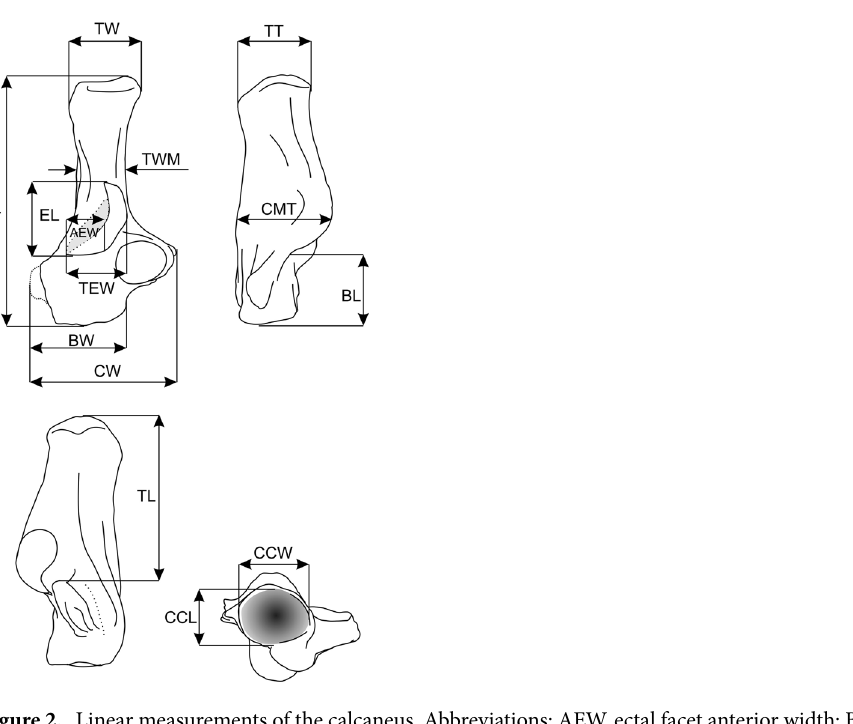
Figure 2. Linear measurements of the calcaneus. Abbreviations: AEW, ectal facet anterior width; BL, calcaneal body length; BW, calcaneal body width; CCL, calcaneocuboid facet length; CCW, calcaneocuboid facet width; CL, calcaneus length; CMT, calcaneus maximum thickness; CW, calcaneal width; EL, ectal facet length; TEW, ectal facet total width; TL, tuber calcanei length; TT, tuber calcanei thickness; TW, tuber calcanei width; TWM, tuber calcanei width in mid-length. (Figure created in Corel Draw X4 (v.14.0.0.567) by Łucja